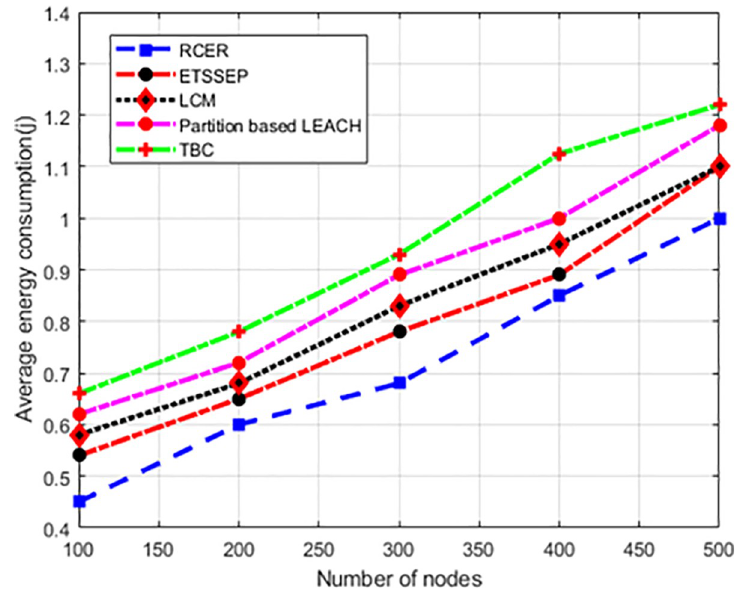
Fig 10. Energy consumption in high-density